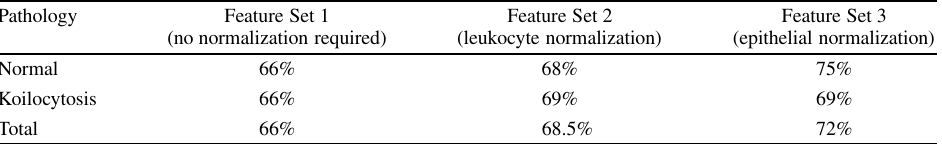
Classification matrix cells-by-cells analysis: Results of the stepwise discriminant analysis of negative and HPVAC lesions using the three features sets. F -to-enter, F -to-removed: 20 Pathology